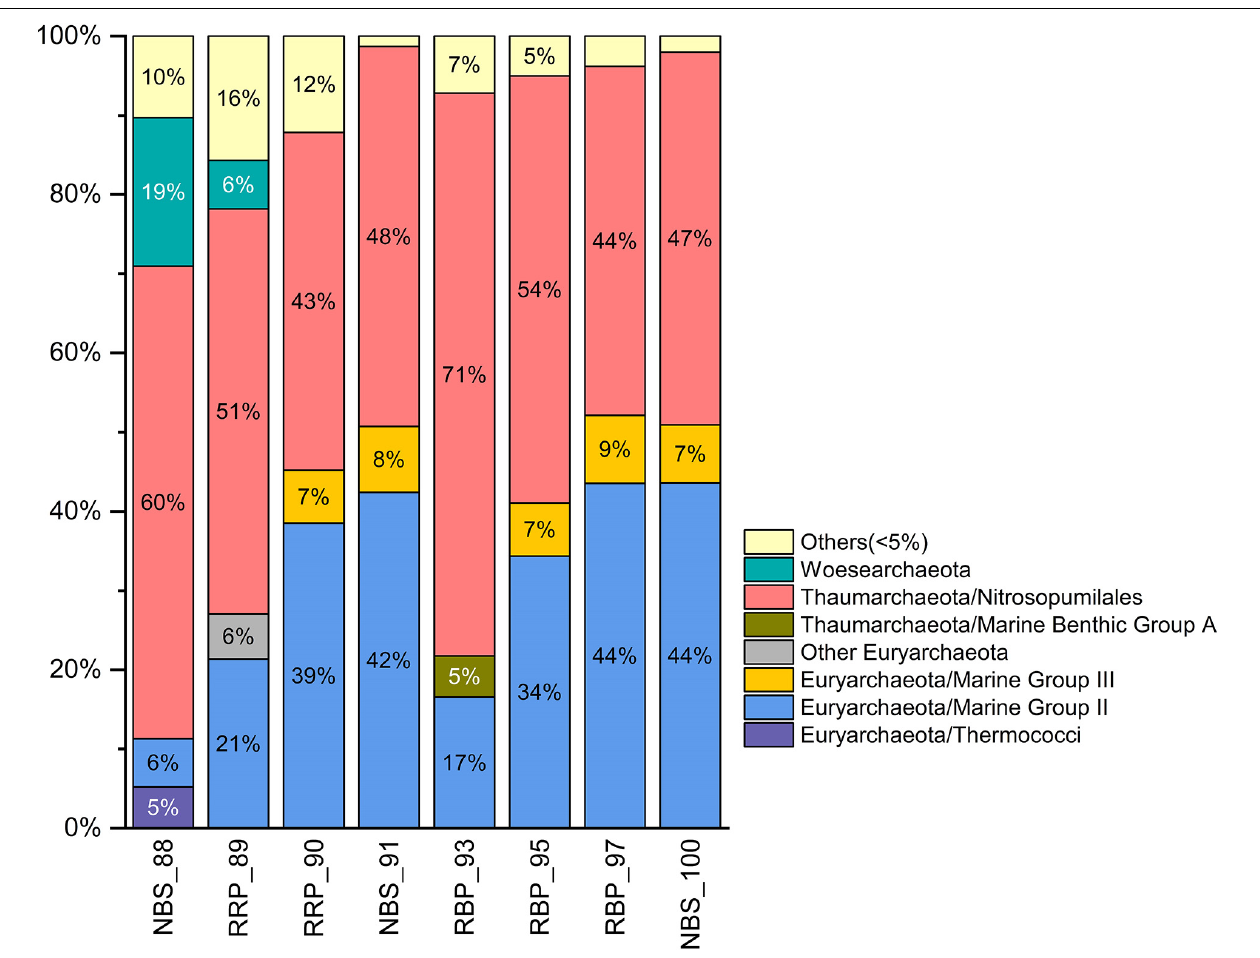
FIGURE 6 | Histogram of archaeal communities in the rising buoyant plumes and ambient near-bottom seawater collected by HOV Jiaolong. Only archaeal lineages > 5% abundance are shown. The rest are classified into “others”